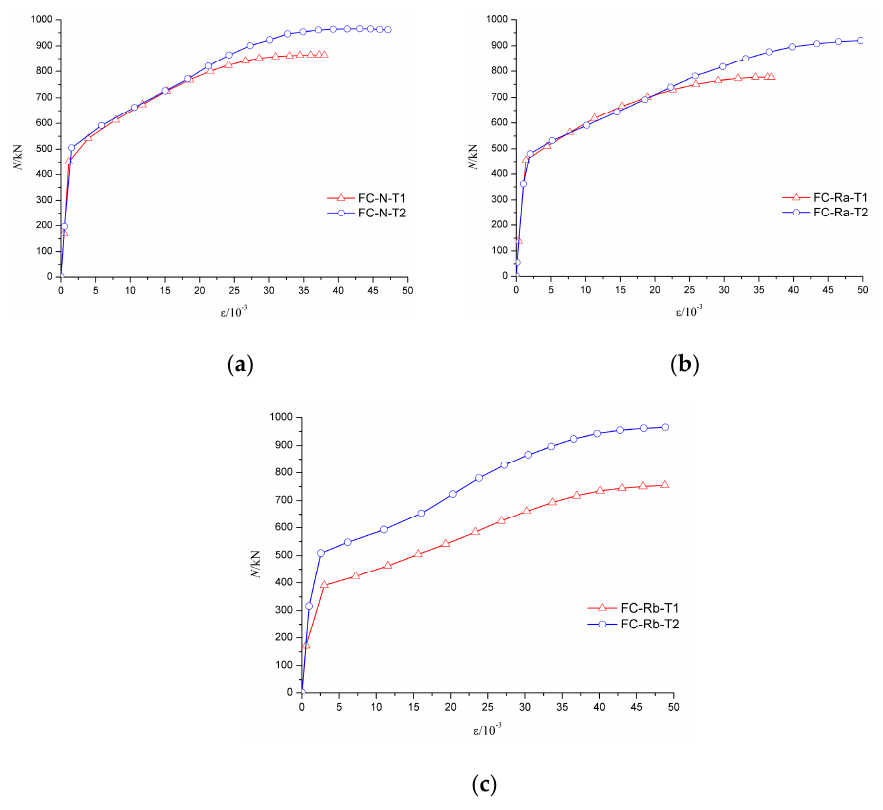
Figure 24. Influence of wall-thickness on N- ε curves. ( a ) Fine aggregate concrete; ( b ) Recycled aggregate concrete (RP RCA = 100%); ( c ) Recycled aggregate concrete (RP RCA = 100% and RP RFA = 100%).